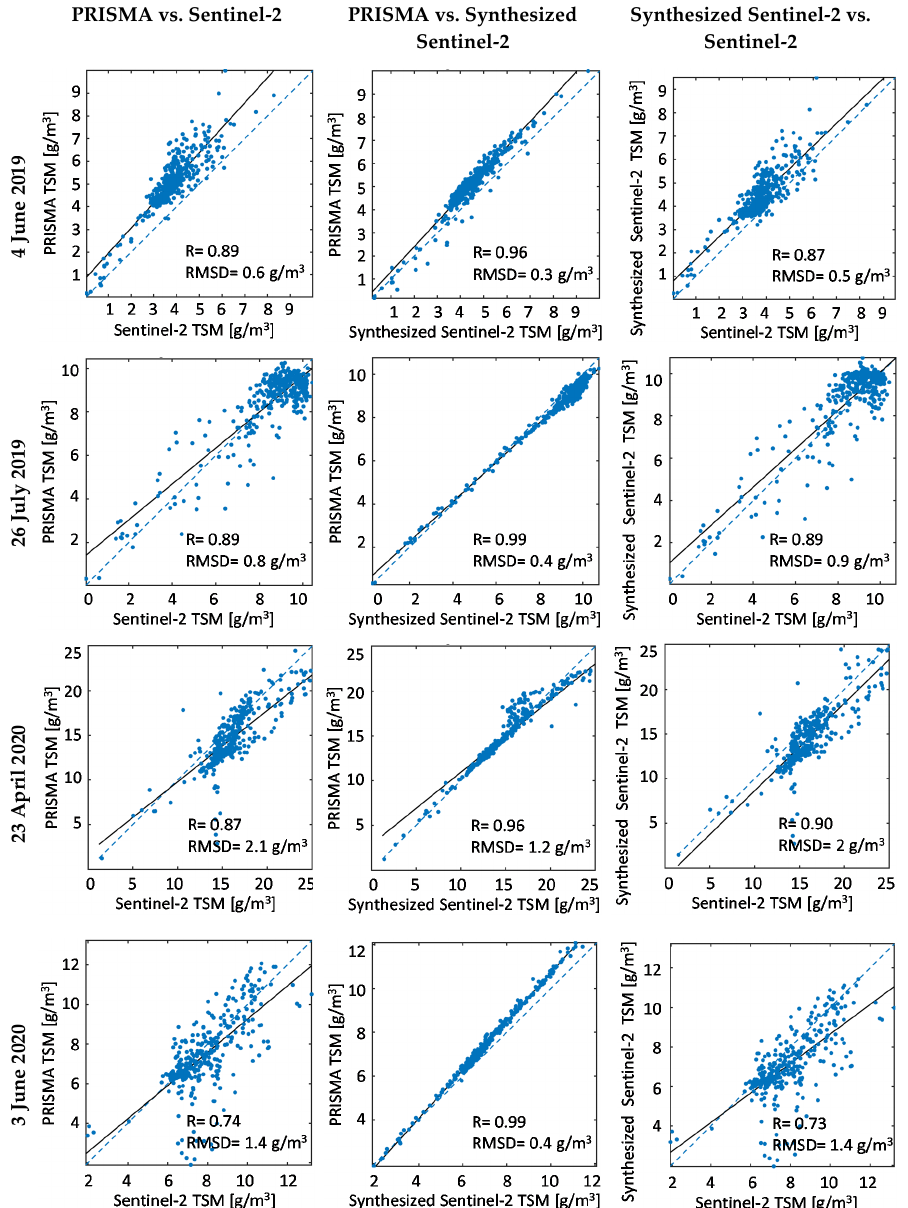
Figure 9. Distribution of the retrieved constituents (TSM, Chl-a, and CDOM) from PRISMA, synthesized Sentinel-2 (PRISMA resampled), and Sentinel-2 images.